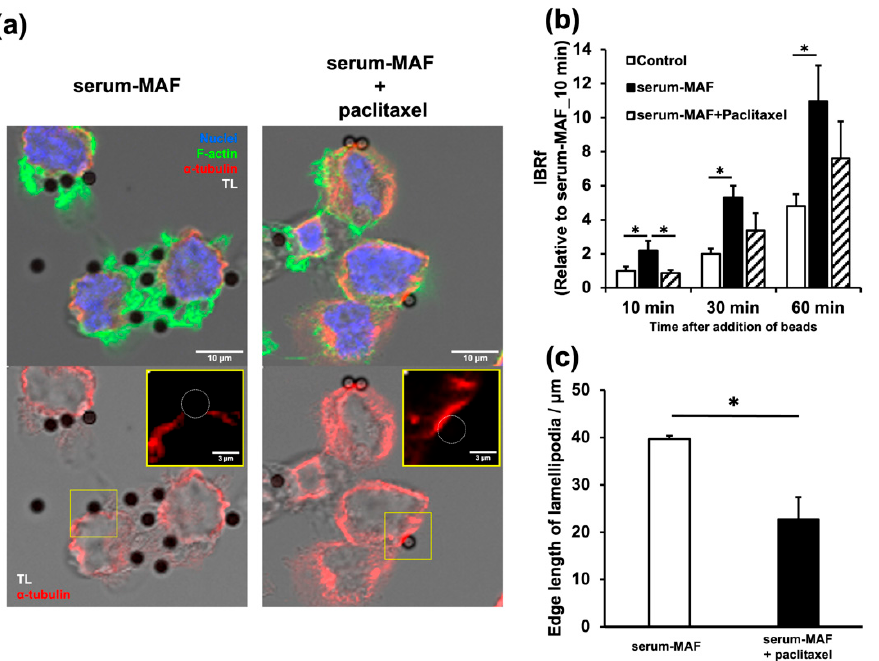
Figure 4. Effects of microtubule stabilization on phagocytosis. ( a ) Serum-MAF-activated macrophages pre-incubated with (right panel) or without (left panel) paclitaxel (10 µg/mL) for 60 min were incubated with beads for 10 min. A three-color image (upper) of α -tubulin (red), F-actin (green), and nuclei (blue) or a single-color image (lower) of α -tubulin (red) were merged with a grey scale of transmitted light (TL) image. Cortical microtubule staining was enhanced, and actin accumulation and bead attachment were inhibited by the paclitaxel treatment. Scale bar: 10 µm. A single red channel image of the boxed area was enlarged at the upper-right corner. The circle in the enlarged images indicate the invisible beads. Scale bar in the insert: 2 µm. ( b ) Phagocytic activity was evaluated by IBRf at 10, 30, and 60 min after bead addition. *; significantly different as determined by one-way ANOVA between the indicated groups (n = 3, * p < 0.05). On the contrary, the differences between the serum-MAF-activated macrophage and the serum-MAF-activated + paclitaxel macrophage at 30 and 60 min after bead addition were not significant (one-way ANOVA; n = 3, p = 0.091, p = 0.297, respectively). ( c ) Quantification of membrane ruffling. * p < 0.05, compared to the serum–MAF-activated control (t-test; n = 4).